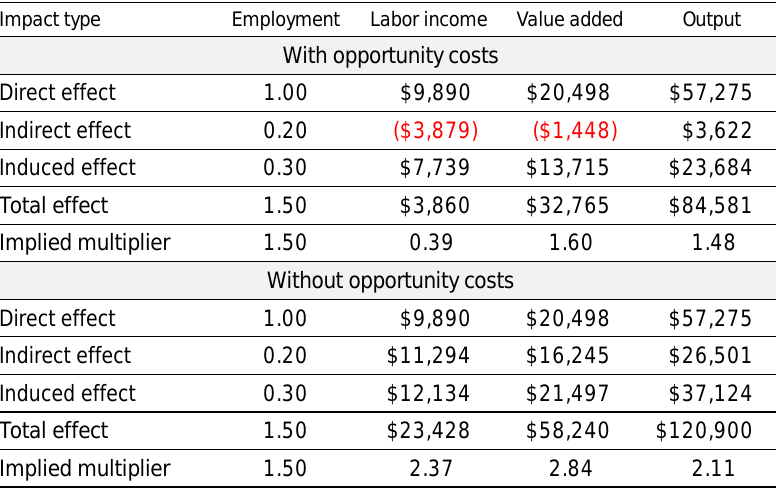
Table 5. Summary of Impact Results for the Georgia Study Area, With and Without Opportunity Costs Impact